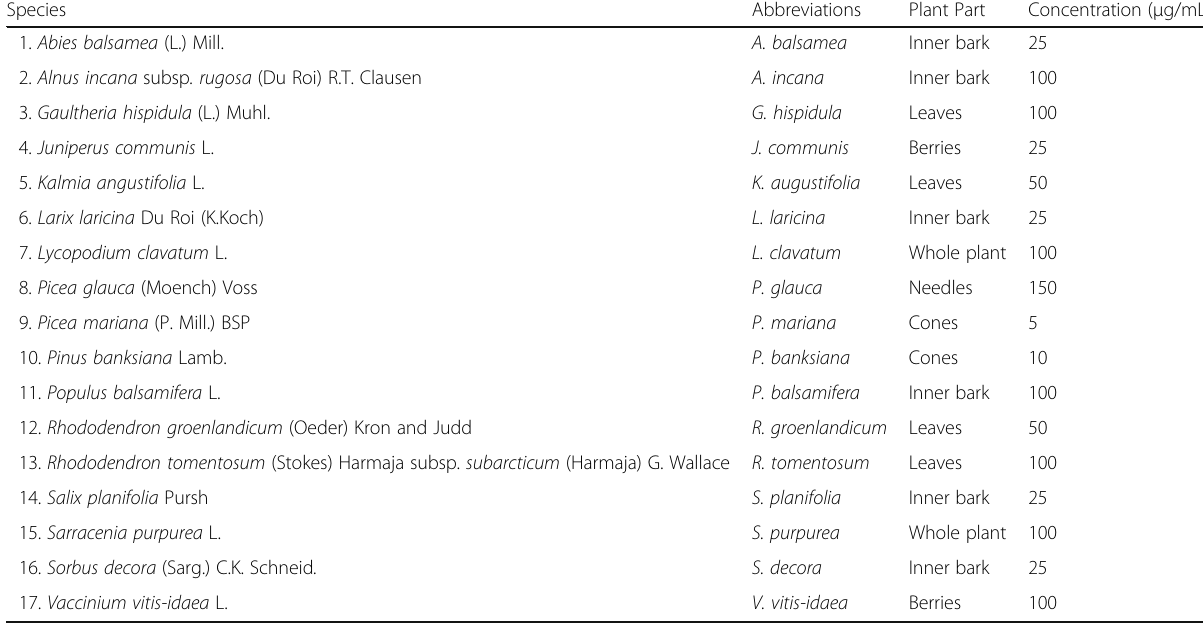
Table 2 List of investigated plant species and the concentrations of the extracts tested in MDCK cells